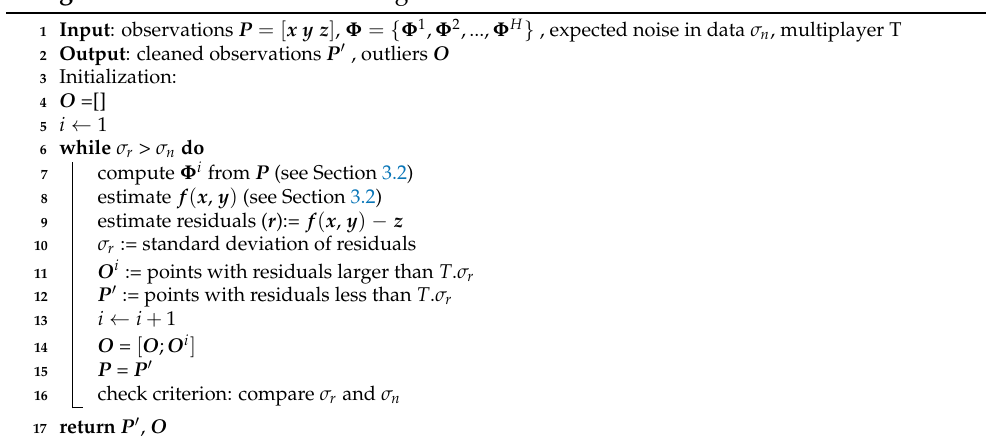
Algorithm 1: Outlier detection